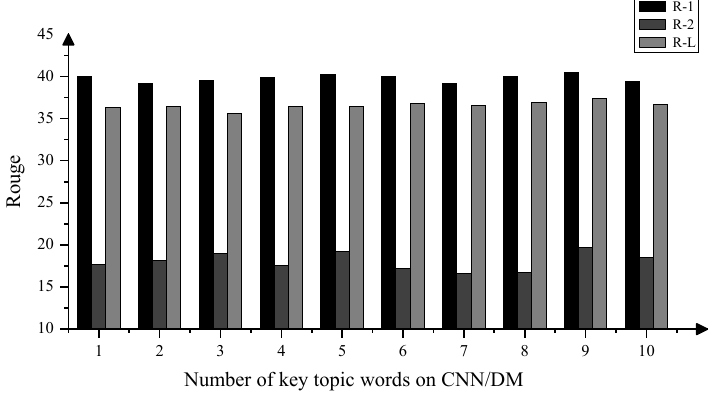
Figure 5. Correlation between summaries quality and the number of topic terms in the CNN/DM dataset (number of topics is 43).